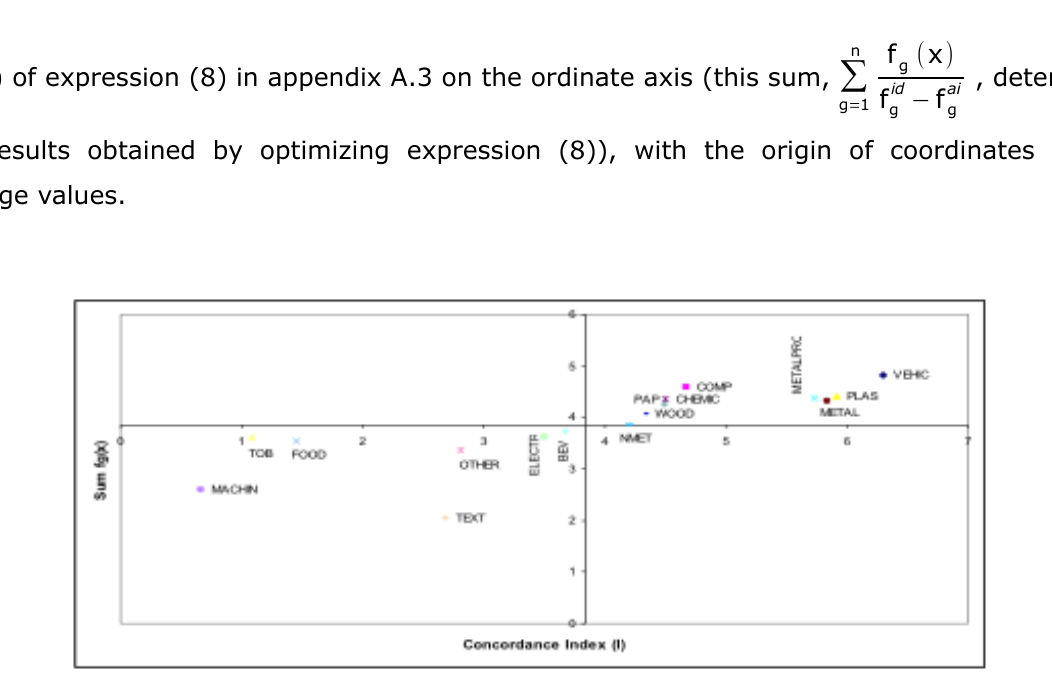
Figure 3. Concordance index BC/industries and the sum of fg(x) attributes